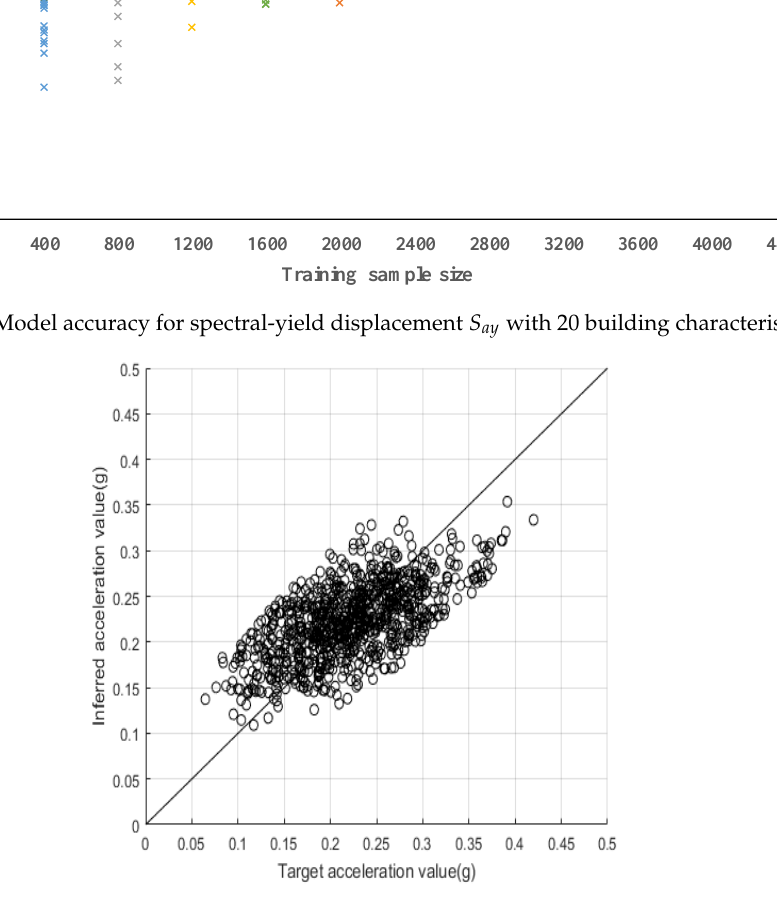
Figure 11. Test results of 4400 training samples for spectral-yield displacement 𝑆 𝑎𝑦 with 20 building